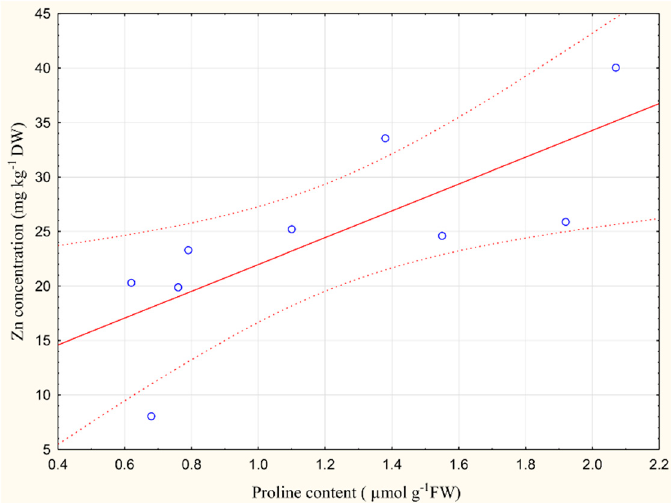
Figure 5. The values of the Pearson’s correlation coefficient ( p < 0.05) between Zn content and proline accumulation in the root of Trapa natans L.